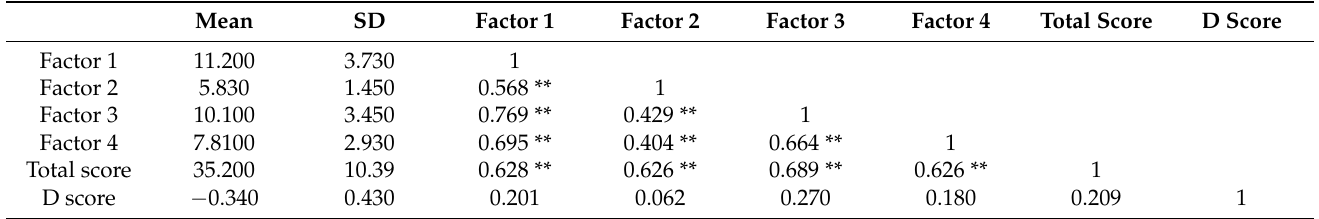
Table 7. Results of Spearman correlation analysis between D score and DRRS score.